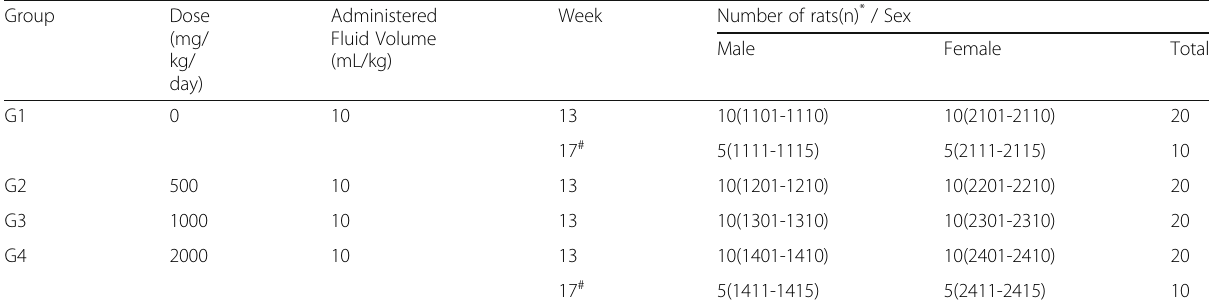
Table 1 Dosage groups used for the 13-week repeated dose oral toxicity study with SD rats